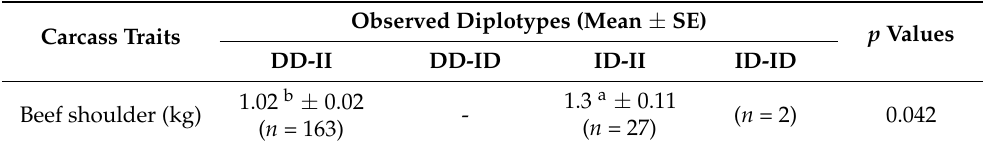
Table 8. Associations of different diplotypes of the P1-Ins-4-bp and P2-Del-8-bp InDels with carcass traits in the female SDBCGR population.